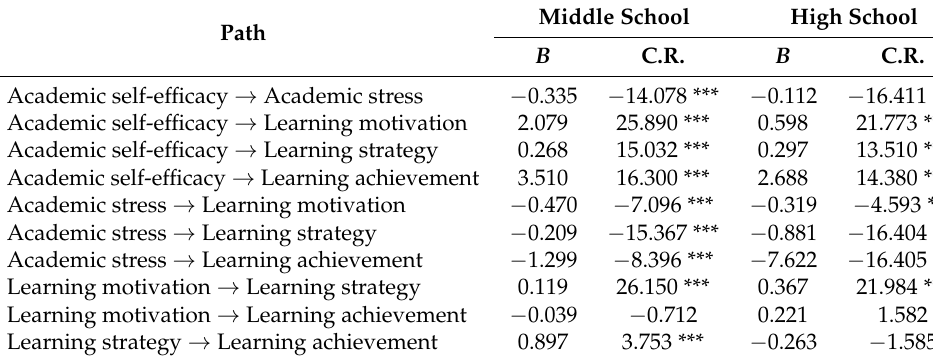
Table 6. Unstandardized Regression Coefficients of the Structural Equation Models of Middle and High School Student